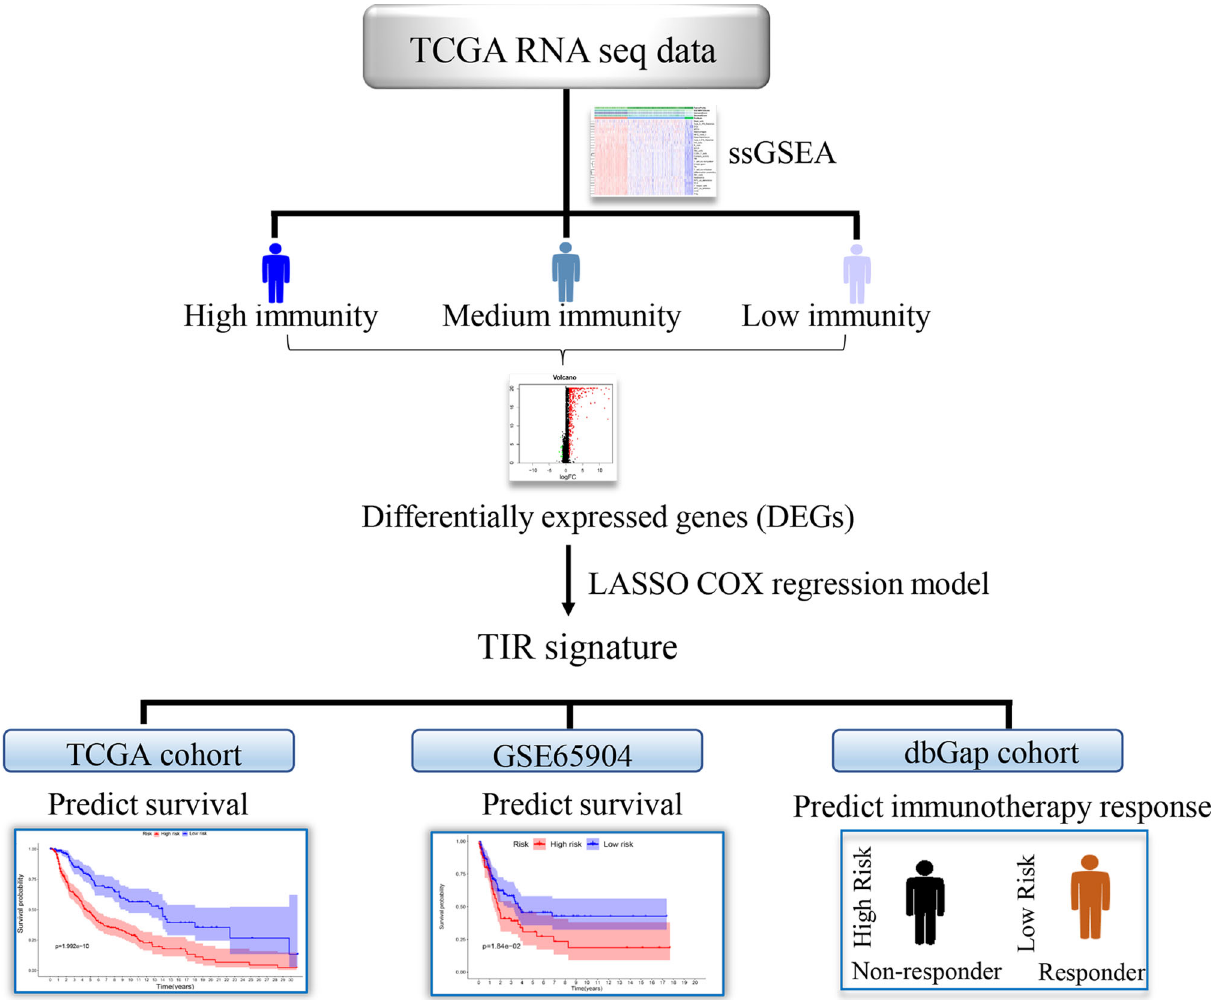
Fig. 7 Graphical summary. The fl ow chart illustrates the process followed to identify a four-gene signature that predicts survival and anti-CTLA4 immunotherapeutic responses based on immune classi fi cation of